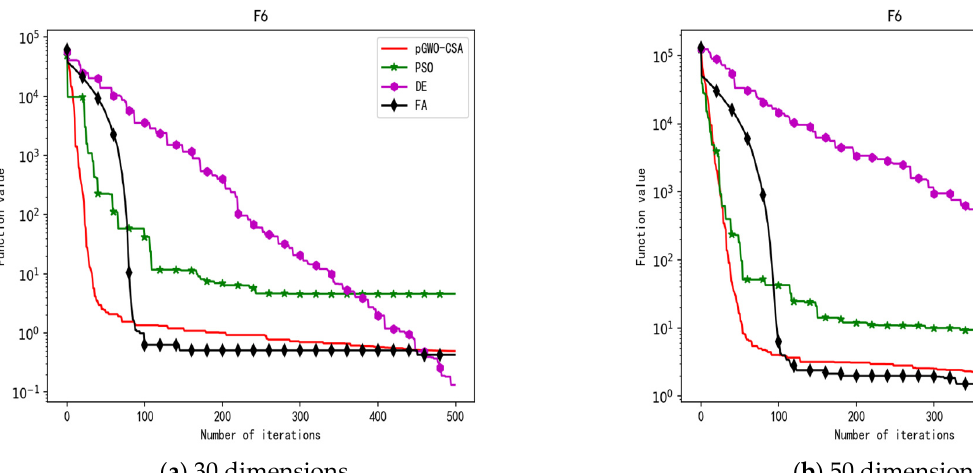
Figure 10. Convergence curve of test function F6.